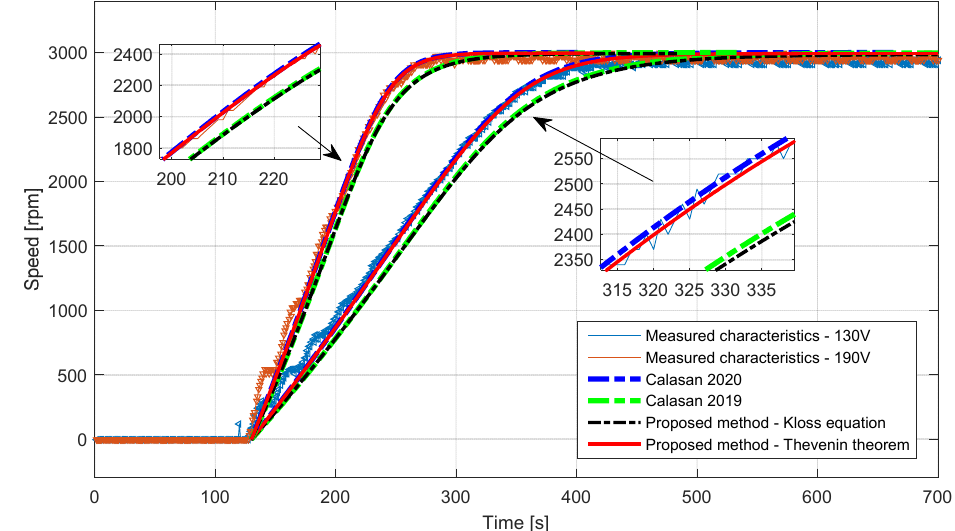
Figure 5. Measured and simulated speed-time characteristics of IM#1.